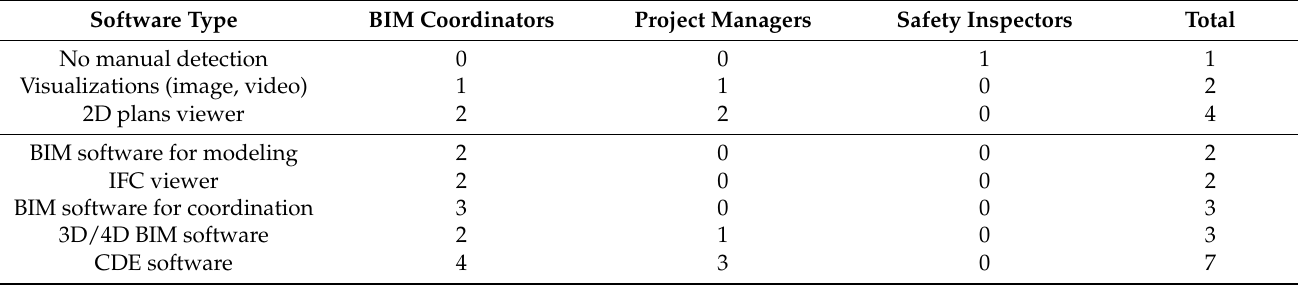
Table 5. Responses to the question: “ What kind of software do you currently use for manual hazard detection?” 1. Software Type